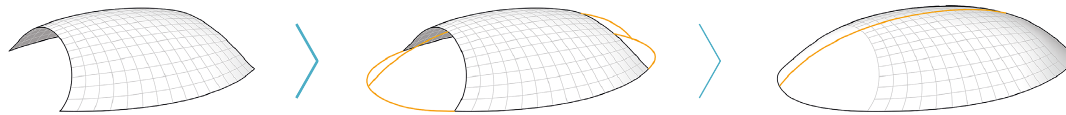
Figure 21: Completion of the full